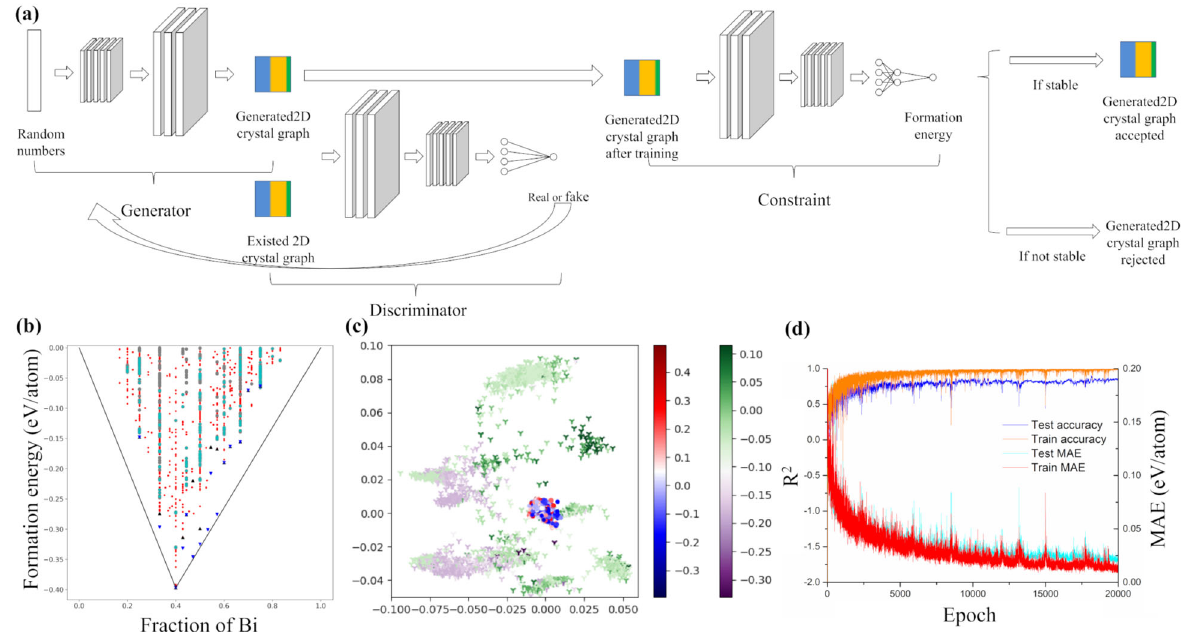
Fig. 2 Illustration on the DCGAN + constraint model. ( a ) Schematic diagram of the DCGAN + constraint model; ( b ) Scatter plot of formation energy vs. composition for structures generated by DCGAN and DCGAN + constraint models, where the black line represents the convex hull, red points denote the crystal structures considered in our machine learning database, gray circles indicate the generated structures, cyan stars denote the DCGAN + constraint structures, blue triangles indicate the experimentally achievable phases (cf. Supplementary Table 7), black triangles mark the crystal structures of the available Bi-Se phases in the Bi-Se database; ( c ) Distribution of the crystal structures in the latent space, the circles denote the structures in the Bi-Se database, while the stars denote the generated structures. The color maps denote the corresponding formation energy; ( d ) Learning curves of the training process of the DCGAN model, red and orange represent the MAE and accuracy of the training set, while blue and cyan represent the accuracy and MAE of the test